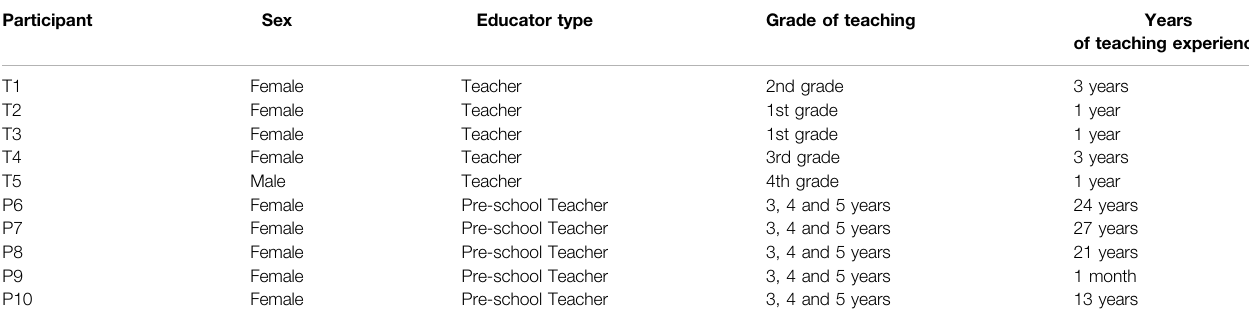
TABLE 1 | Characterization of the